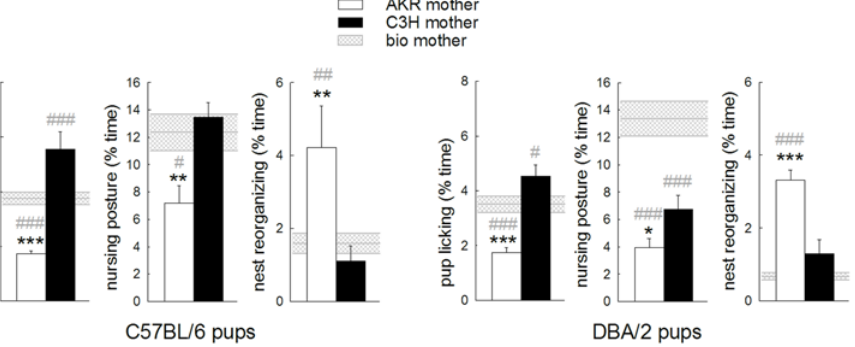
Figure 3. Maternal behavior displayed by AKR and C3H mothers toward C57 and DBA pups. Graphs show the percentage of time spent in pup licking, nursing posture and nest reorganizing activity with C57 pups (left panels) and DBA pups (right panels) averaged over 4 postnatal days (PD 2, 4, 6 and 9). Behavior of the reference mothers (bio mothers) is shown as horizontal hatched bands. Bars represent mean 6 SEM. AKR mothers (white bars) n =9 dams for each pup strain. C3H mothers (black bars) n =7 dams for each pup strain. Bio mothers (hatched bands) n =15 for C57 dams and n =8 for DBA dams. * p , 0.05, ** p , 0.01 and *** p , 0.001 compared to C3H mothers. # p , 0.05, ## p , 0.01 and ### p , 0.001 compared to bio